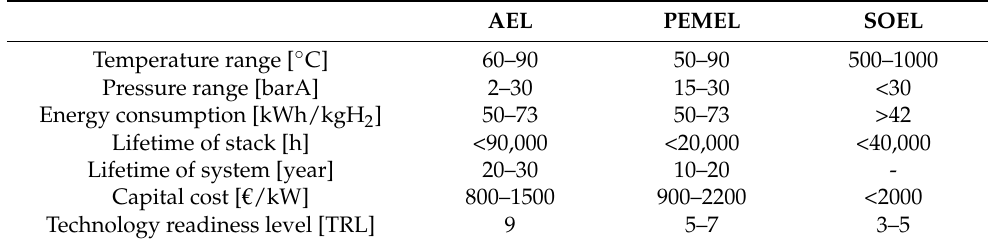
Table 8. Main characteristics of electrolyser types. Based on